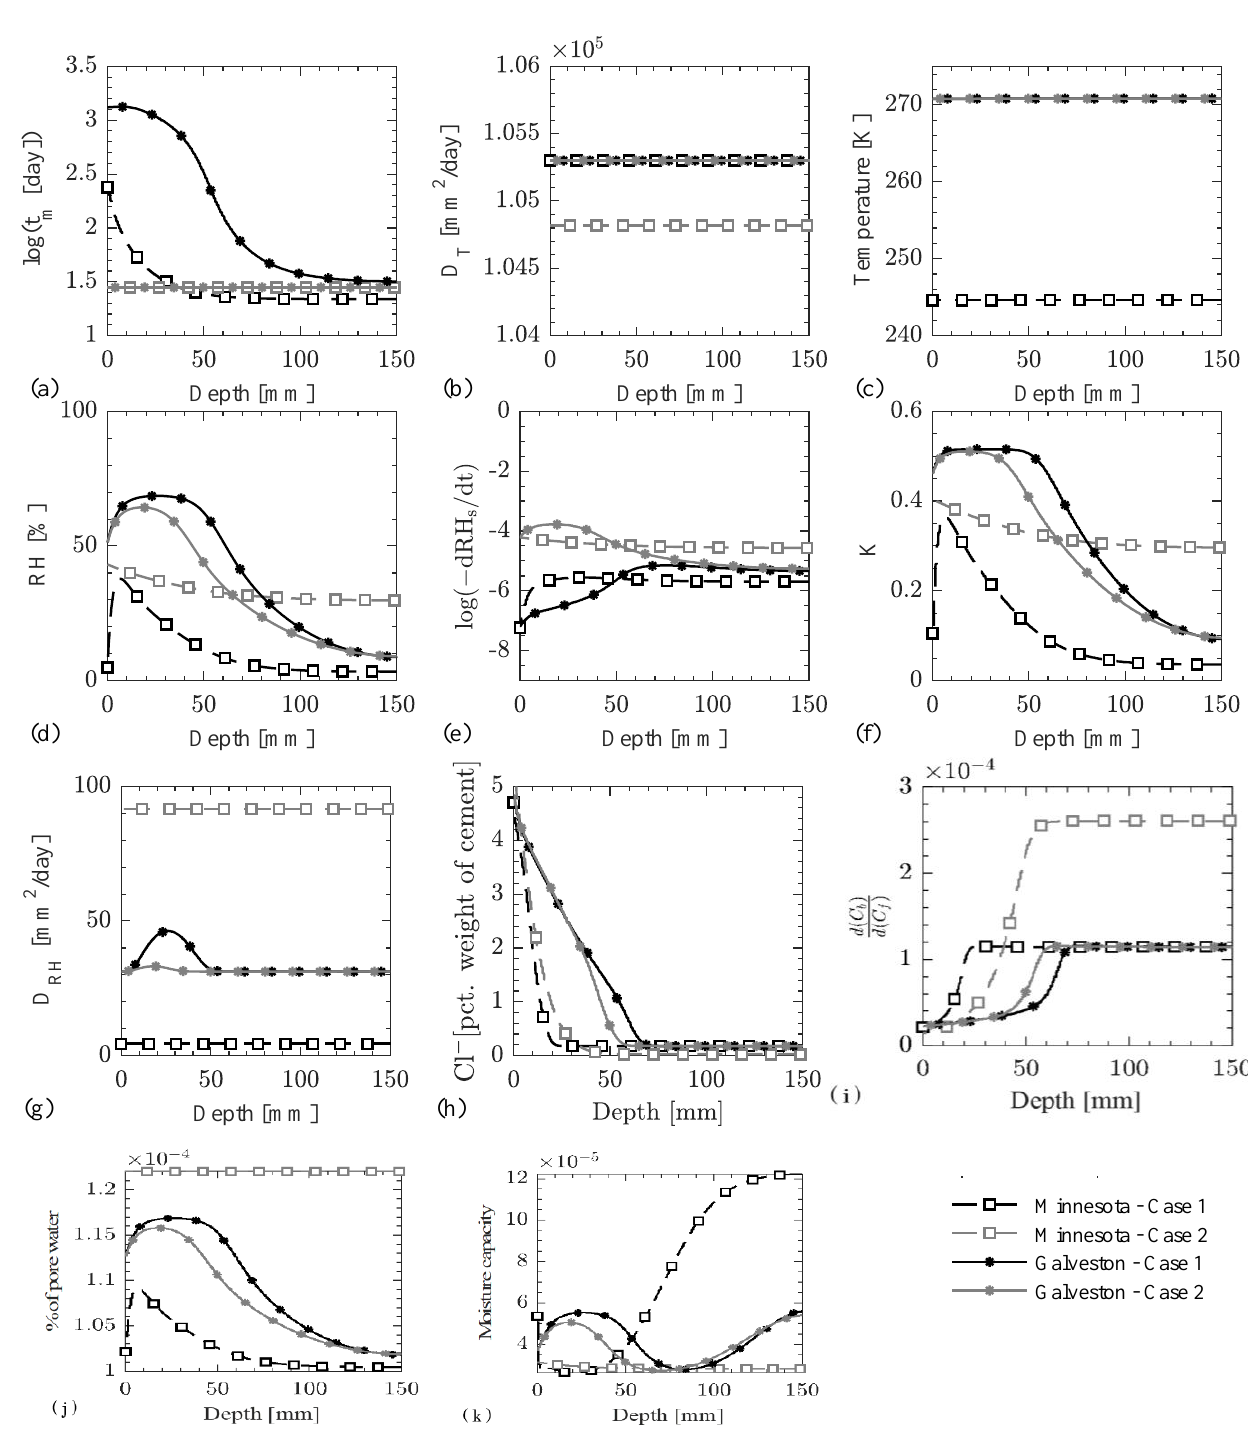
Figure 13. Profiles at the end of 10 years of exposure across concrete depth of ( a ) equivalent maturation time; ( b ) heat diffusion coefficient; ( c ) temperature; ( d ) RH profile; ( e ) rate of self-desiccation of RH, dRH s diffusion in governing equation for RH diffusion, K; ( g ) RH diffusion coefficient; ( h ) Cl − concentration; ( i ) Cl − diffusion coefficient; ( j ) bound Cl − concentration; and ( k ) % pore water.